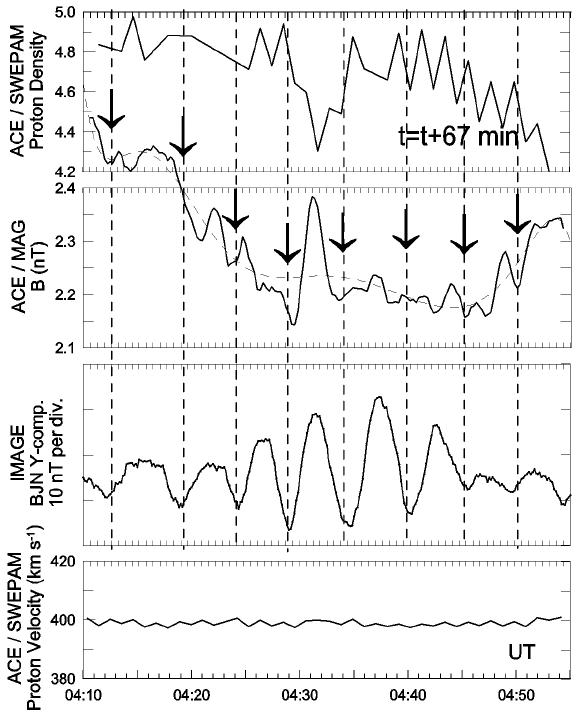
Fig. 7. The solar wind proton density (cm − 3 ) and velocity (km · s − 1 ) , as well as the magnetic field amplitude (nT), as measured by ACE, along with the Y component pulsations at